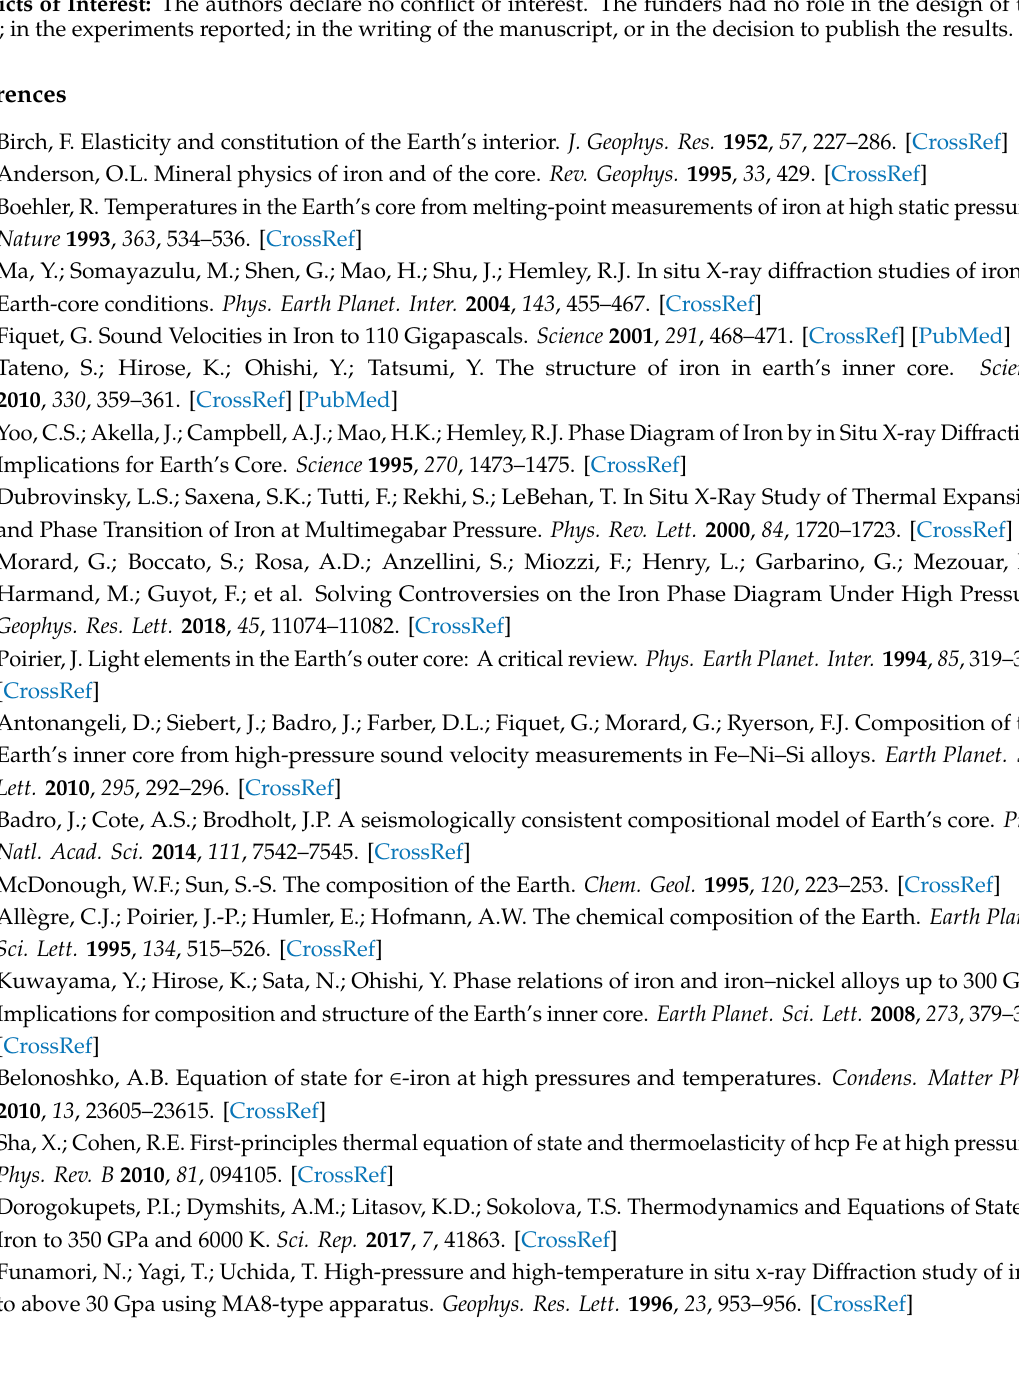
Figure S1: Eos for iron and extrapolations made using di ff erent MgO pressure scales [31,32]; Figure S2: ATEM analyses on a FIB prepared recovered sample after diamond anvil cell experiment. The two data sets used for the refinement are attached as separate